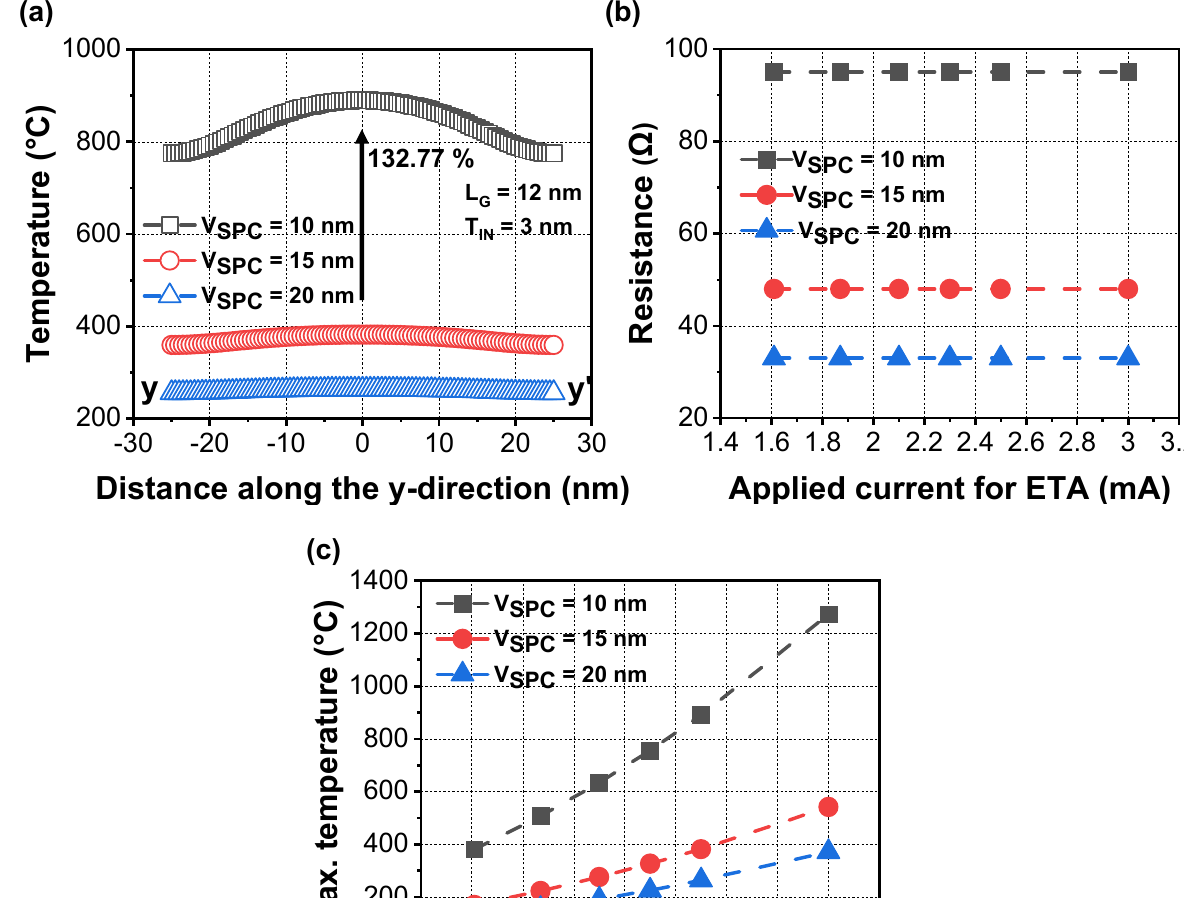
Figure 4. ( a ) Extracted temperature during the ETA in an NS FET with vacuum dielectric with various V SPC . Extracted ( b ) gate-to-gate resistance and ( c ) surface temperature with respect to V SPC and applied current, respectively.